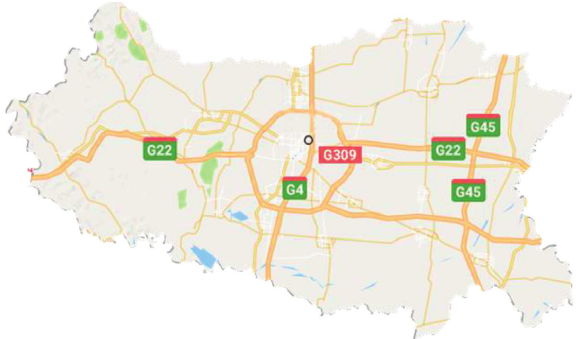
Figure 1: Location map of research area—Handan.